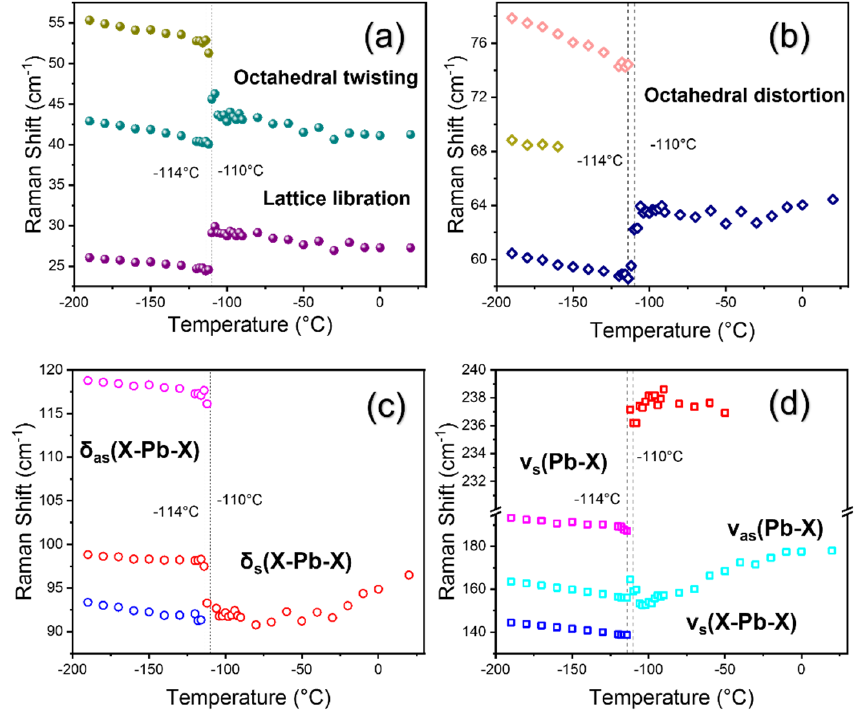
Figure 6. (Color online) Temperature dependences of the Raman shift in a 10–300 cm − 1 frequency range ( a – d ). Phase boundaries are shown as vertical dotted lines along with the phase transition temperatures.